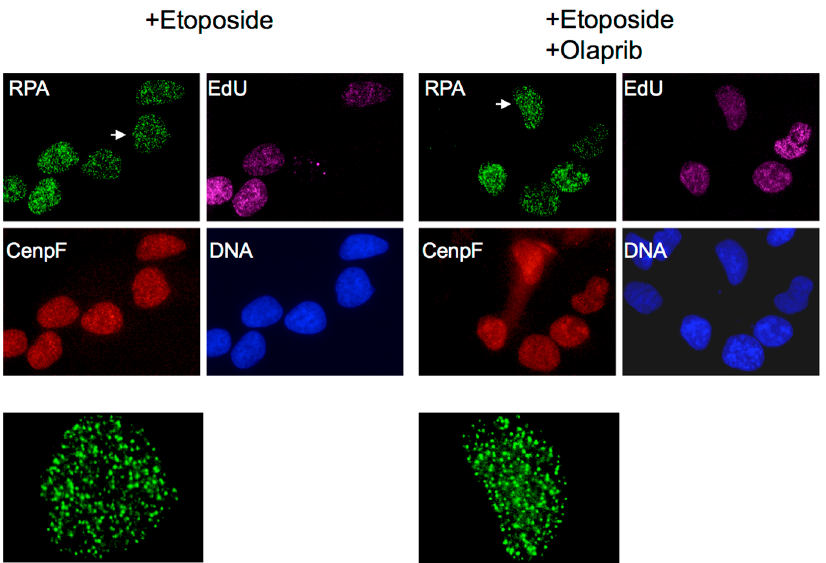
Figure 2. Olaparib does not affect the induction of RPA foci by etoposide. Human osteosarcoma U2OS cells treated with 250 μ M etoposide for 2 h in the presence or absence of 50 μ M olaparib (Selleckchem, Houston, TX, USA). Olaparib and 5 ‐ ethynyl ‐ 2’ ‐ deoxyuridine (EdU; Invitrogen; Carlsbad, CA, USA) were added 30 min and 15 min, respectively, before etoposide. Cells were fixed and stained for RPA, EdU, CenpF, and DNA as previously described [44]. CenpF expression begins in the S phase and peaks in G2.